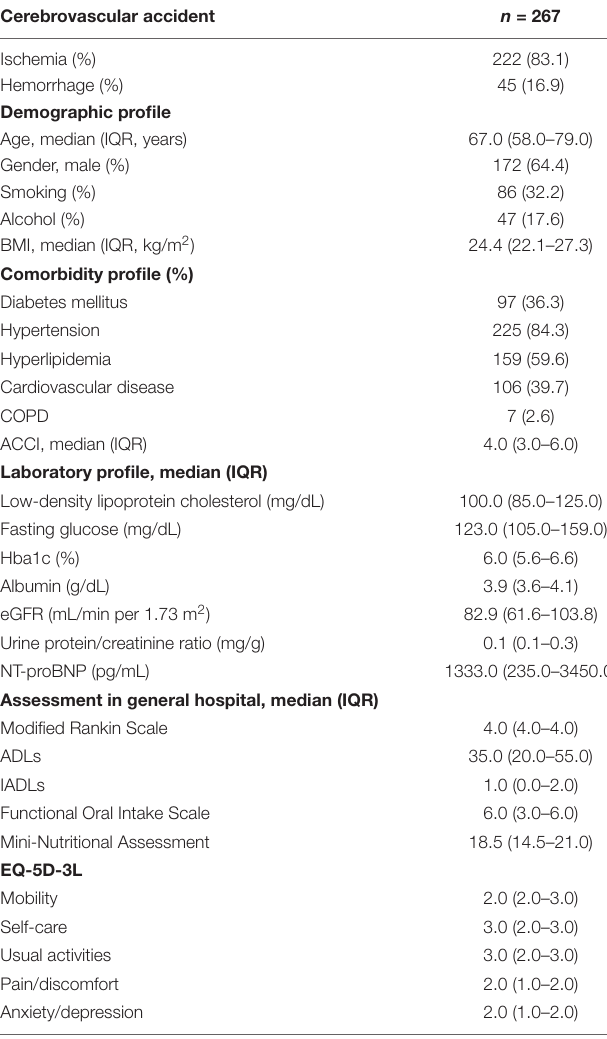
TABLE 1 | Baseline characteristics of patients with cerebrovascular accident. TABLE 2 | Effect of PAC on functional performance and quality of life in patients with